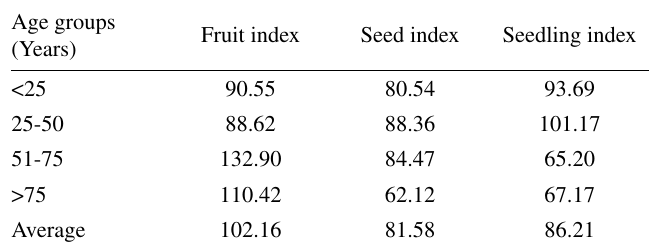
Table 2 - Average fruit index, seed index and seedling index values of four age groups in mangosteen ( Garcinia mangostana